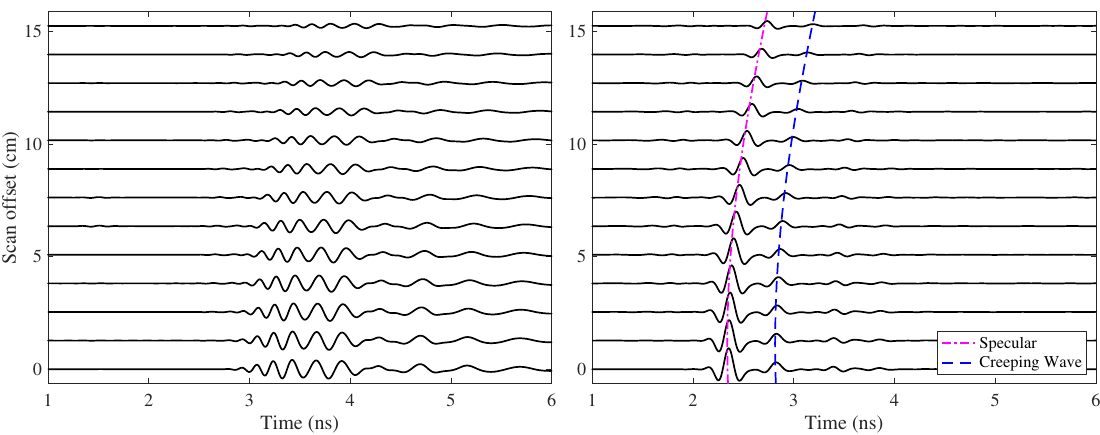
Figure 20. Waterfall plot of measured B-scan showing the dispersed ( left ) and corrected ( right ) time-domain responses from the measured 5.08 cm sphere. Both the specular and creeping wave reflections (denoted by the hyperbolic curves) are evident in the corrected results. Note that the results also contain the time delay due to the